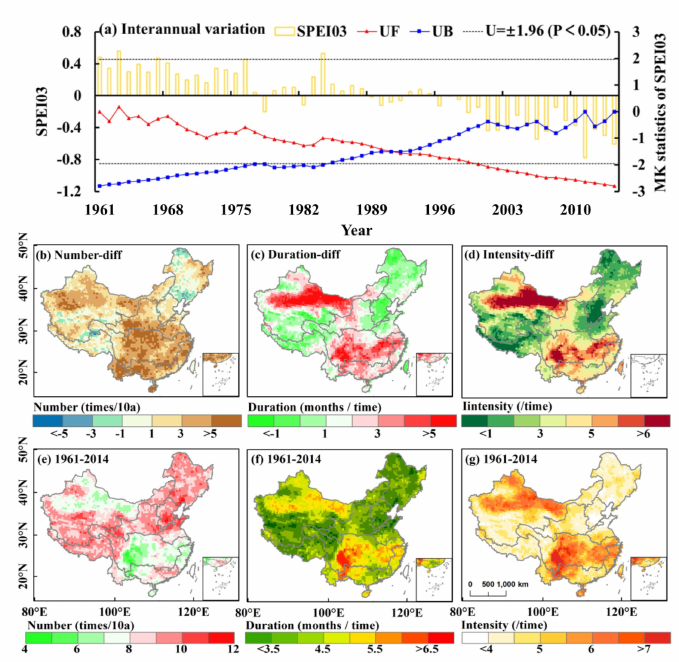
Figure 5. ( a ) Mutation test results of annual mean SPEI03 sequences. The UB, UF, and the 0.05 confidence level (U = ± 1.96, p < 0.05) were plotted. The annual mean number of droughts, mean DD, and mean DI were calculated using SPEI03 for different periods. ( b – d ) show the spa- tial patterns of differences in the drought number, DD, and DI, respectively, from 1961–1994